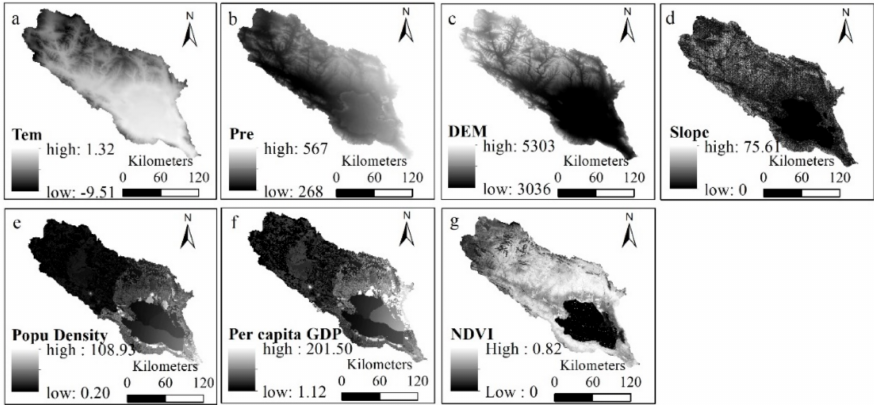
Figure 2. Driving factors of land use change in the QLB. ( a ) annual average temperature; ( b ) annual precipitation; ( c ) DEM; ( d ) slope; ( e ) population density; ( f ) per capita GDP; and ( g ) NDVI.